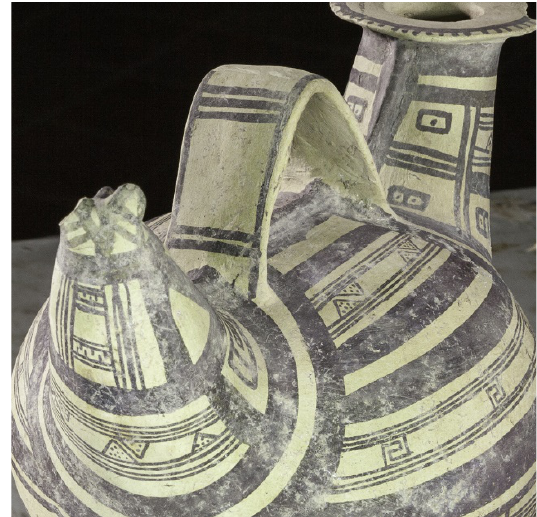
Fig. 12 The new image without blur after